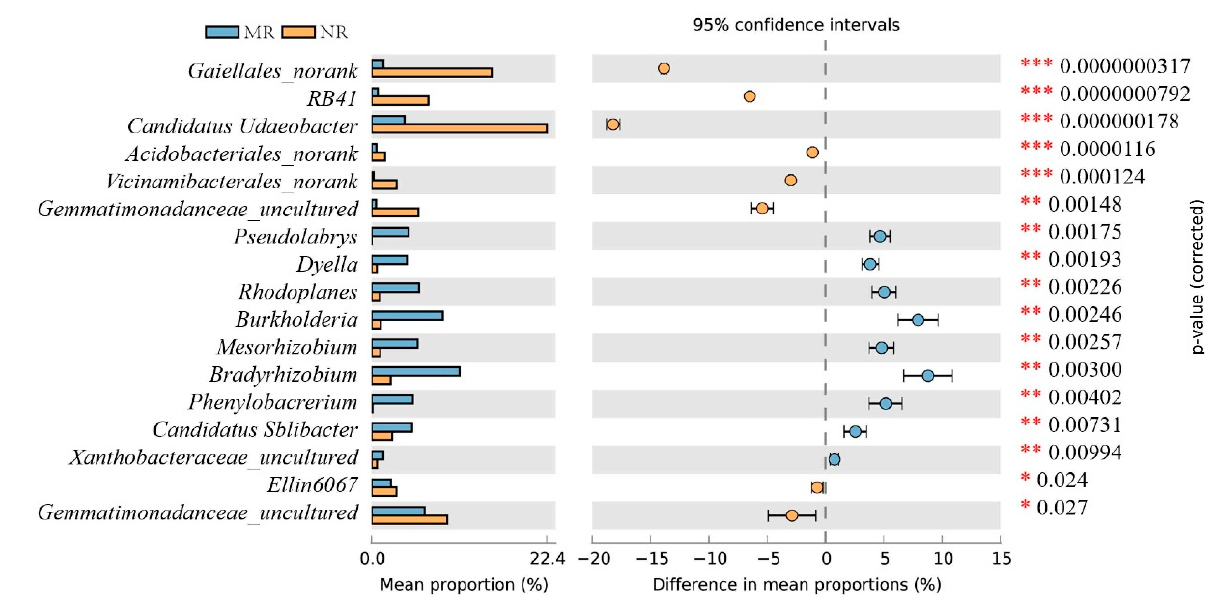
Figure 5. Analysis of differences in the abundance of soil bacterial genera levels. Differences in bacterial abundance between MR and NR. In the figure, “*” indicates a significant difference between the two data sets ( n = 3, p < 0.05); “**” indicates a highly significant difference between the two data sets ( n = 3, p < 0.01); “*** “ indicates a highly significant difference between the two data sets ( n = 3, p < 0.001) using Welch’s t -test.